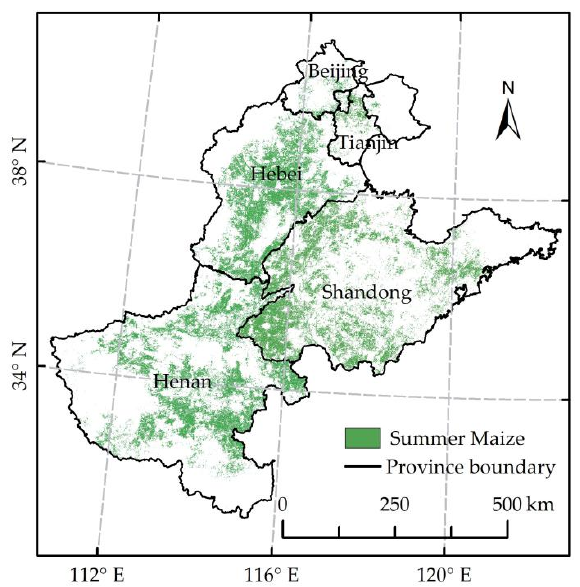
Figure 10. The distribution of the maize planting area in Huanghuaihai Plain in 2012.